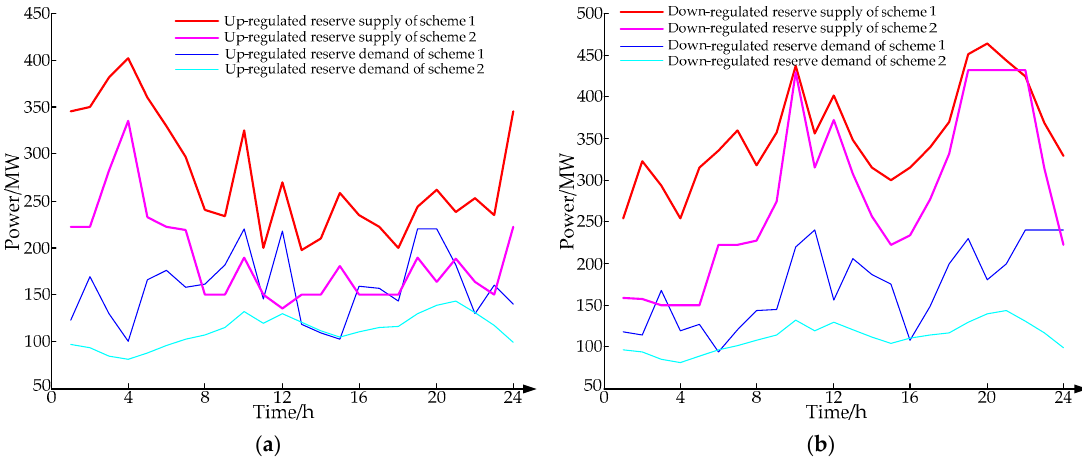
Figure 17. Comparison of reserve demand and supply under different schemes: ( a ) Up-regulated reserve comparison; ( b ) Down-regulated reserve comparison.